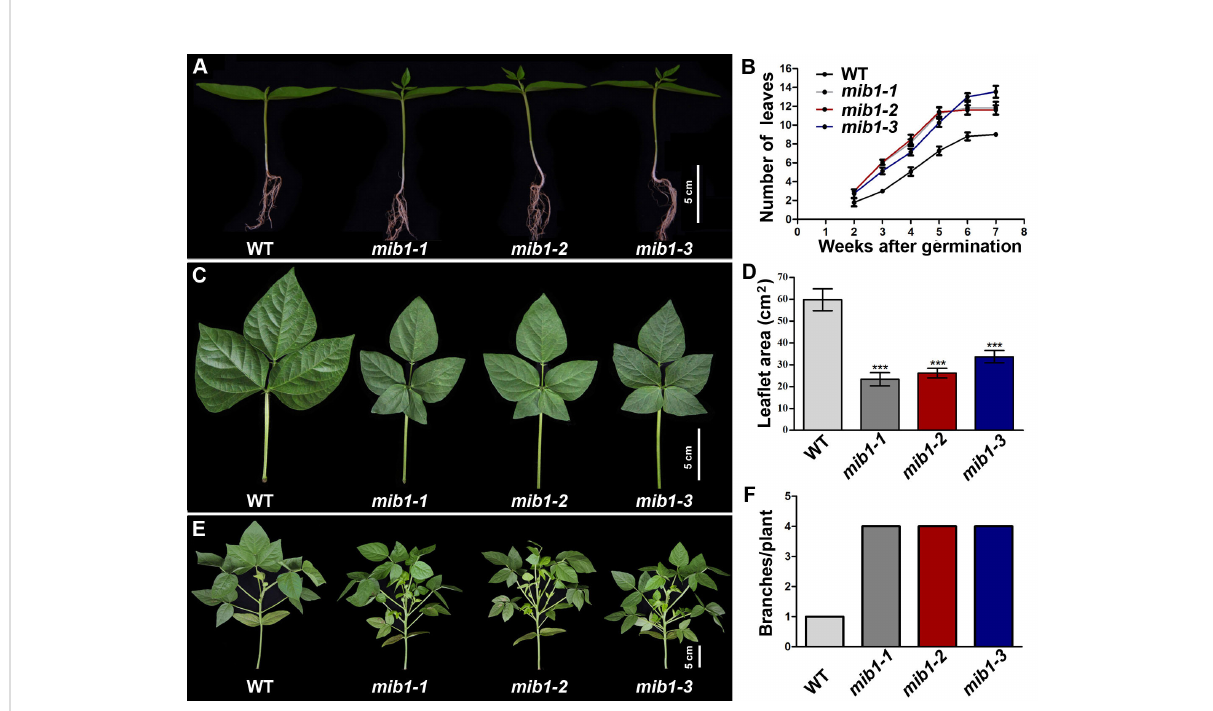
FIGURE 1 Growth rate characterization of WT and mib1 mutants. (A) Two-week-old seedlings of the wild-type (WT) plant and mib1 mutants. (B) The number of compound leaves of WT and mib1 mutants ( n = 10). (C) The fi fth compound leaves of WT and mib1 mutants. (D) The size of the terminal lea fl ets of the fi fth compound leaves of WT and mib1 mutants ( n = 10). (E) Plant architecture of WT and mib1 mutants at the 4 weeks after germination. (F) The number of branches of WT and mib1 mutants at 4 weeks after germination ( n = 10). The data were means ± SD. The Tukey ’ s multiple comparison test was used. *** p <